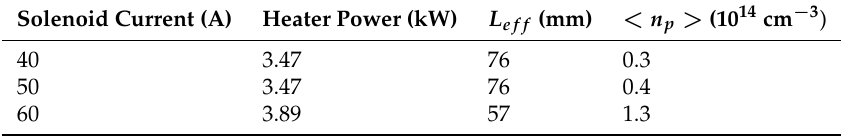
Table 1. Calculated plasma stats for profiles in Figure